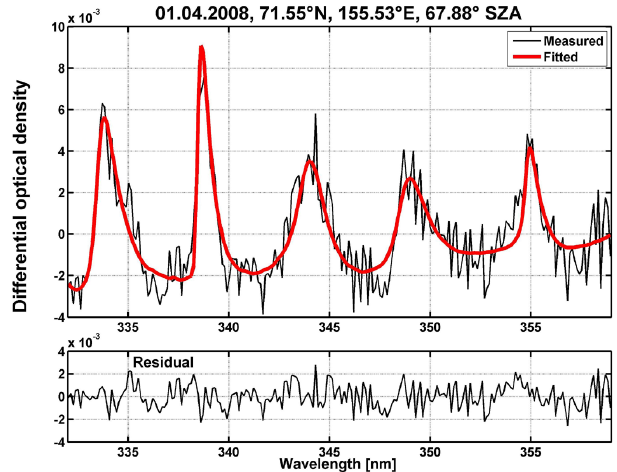
Fig. 2. Example of a fit to the measured BrO differential absorption in the 332–359nm wavelength interval during a tropospheric BrO event. The slant column is 6.14 × 10 14 moleccm − 2 .